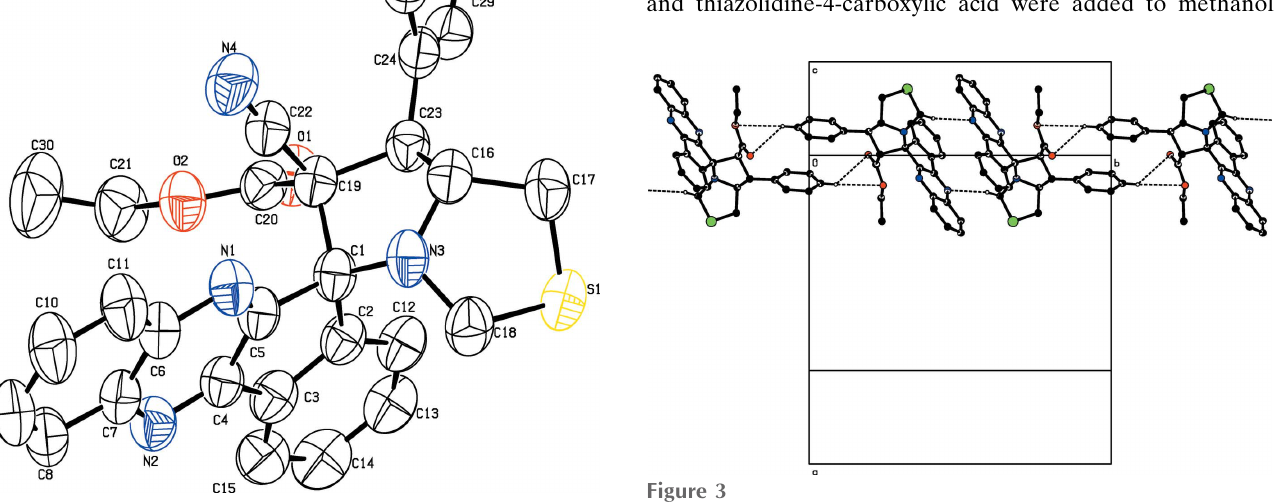
Figure 1 Displacement ellipsoid plot (50% probability level) of the title compound, showing the atom-labelling scheme. H atoms have been omitted for